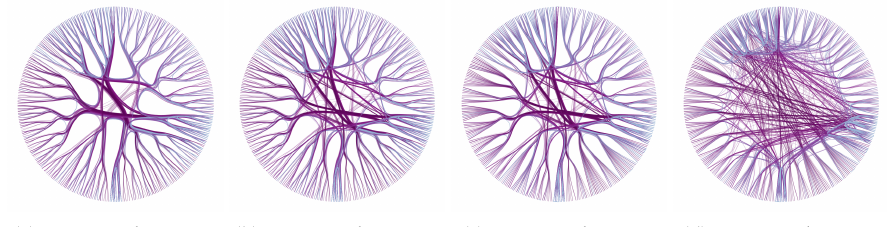
Figure 10. Multiples bundling configurations varying the interval of intermediate